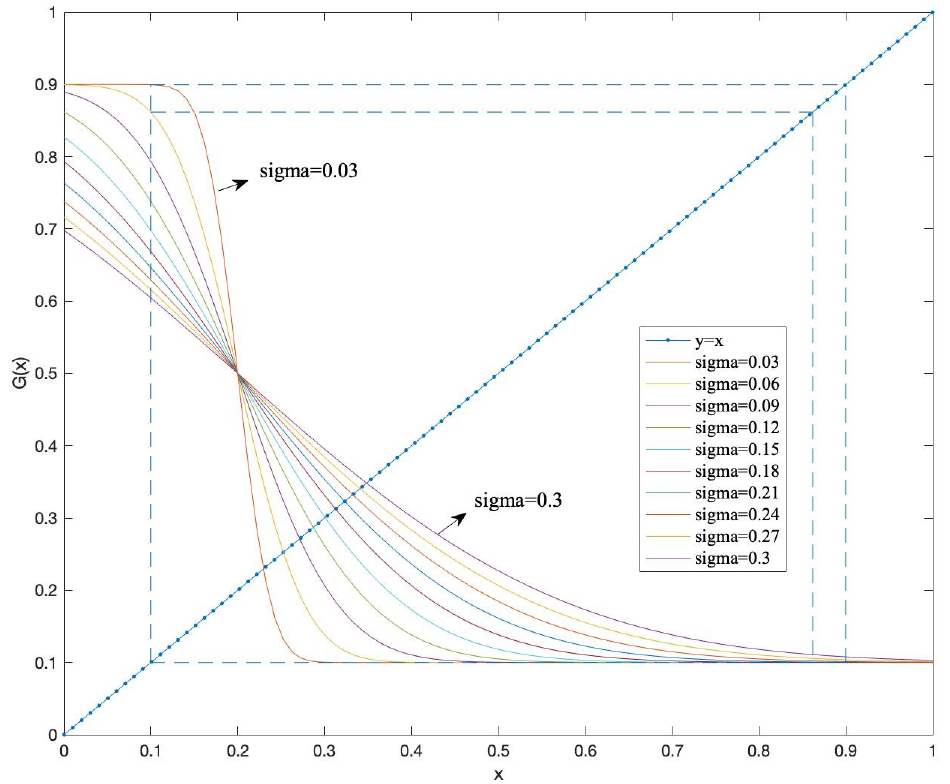
Figure 1. Gaussian distribution with a small proportion of anti-conformist agents ( q = 0.95), m = 0.3.